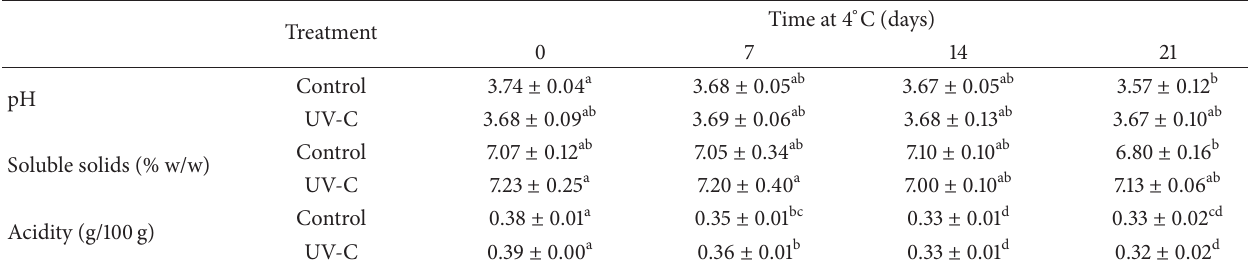
Table 1: pH, soluble solids content, and titratable acidity in control and UV-C treated (12.5 kJm −2 ) carambola slices stored for 0, 7, 14, and 21d at 4 ∘ C. The values represent the mean ± standard error ( 𝑛 = 3 ). Different letters indicate differences on Fisher’s test ( 𝑃 < 0.05 ).